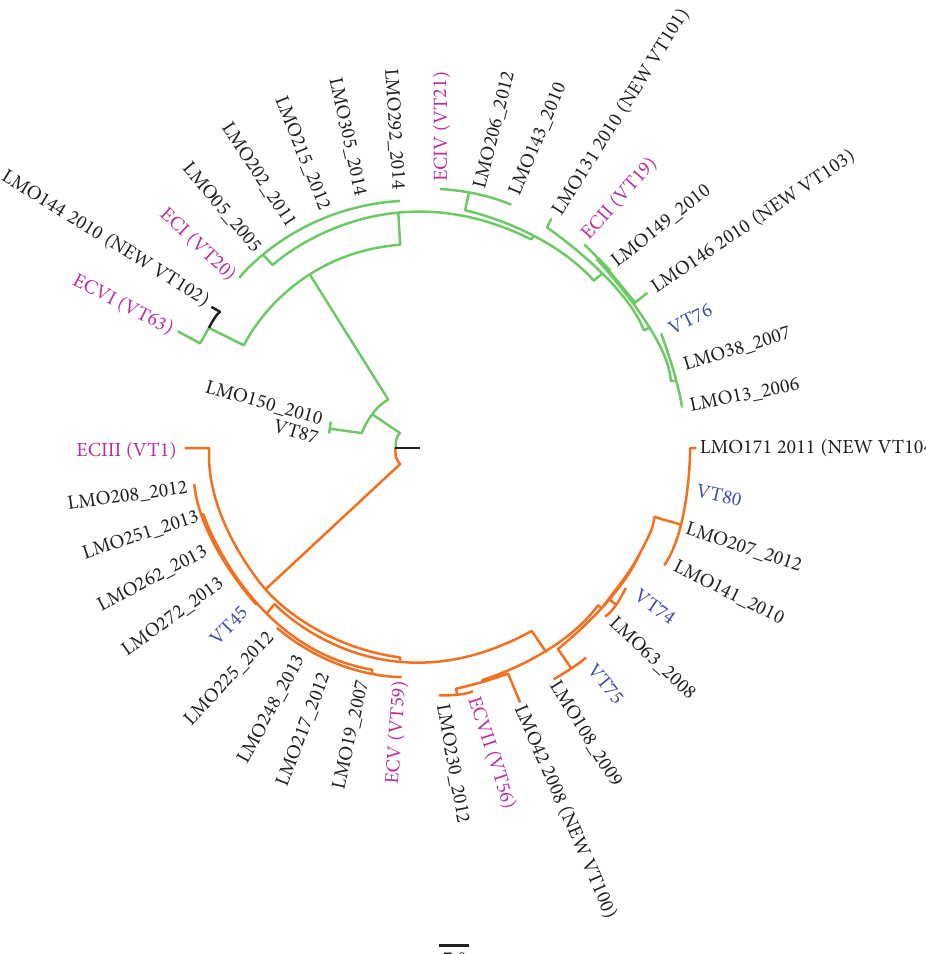
Figure 4: Unrooted neighbor-joining tree computed in MEGA6 [26] for Multi-Virulence-Locus Sequence Typing data obtained for the 29 pregnancy-related isolates of Listeria monocytogenes isolates collected in Lombardy, Italy, from 2005 to 2014. Green indicates isolates of serotype 4b and orange corresponds to isolates of serotype 1/2a. Epidemic Clones (ECs) and non-ECs virulence type (VT) reference strains are highlighted in pink and blue,